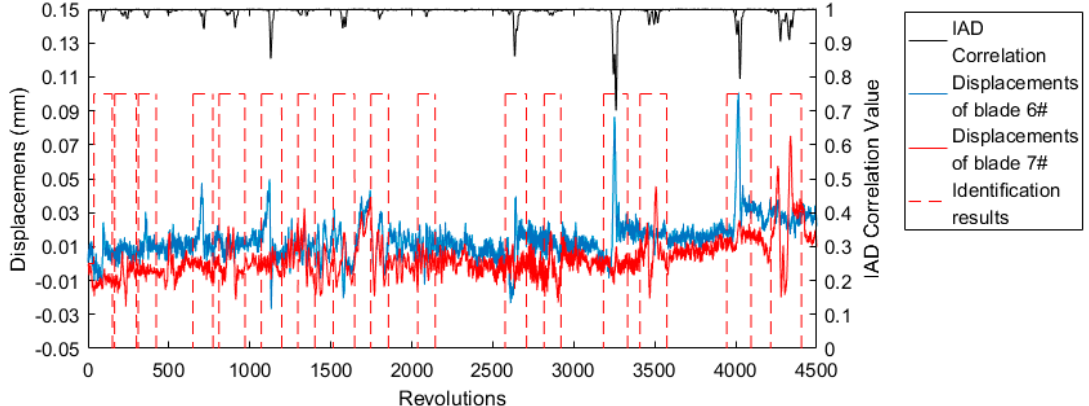
Figure 7. Identification results of blade 6# and 7# using Equation (4).